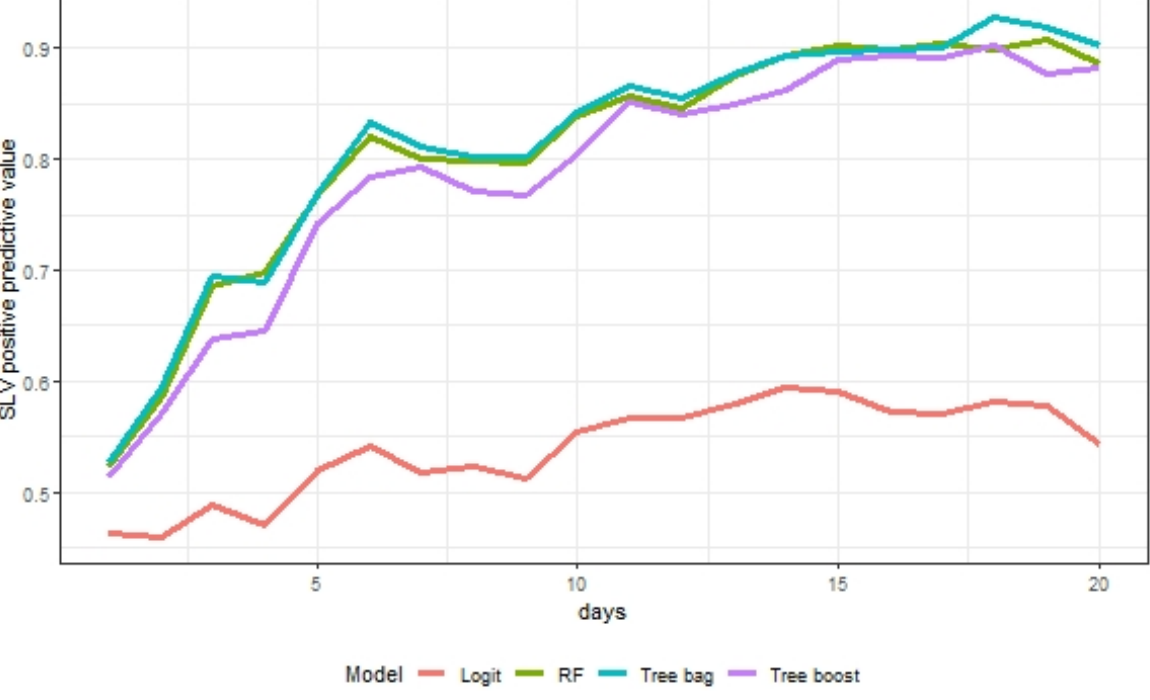
Figure 9. This figure shows the multi-period positive predictive values accuracy for SLV price direction. Figure 10 shows the negative predictive values for GLD. As in the case of the positive predictive values for GLD, RFs and tree bagging provide the most accurate negative pre- dictive values. Tree boosting is slightly less accurate than RFs and tree bagging. The logit model has the lowest accuracy. B e tween 1 and 5 days, accuracy increases from 0.5 to 0.8 for the RFs and tree bagging models. After 10 days, negative predictive values for RFs and tree boosting varies between 0.85 and 0.90. The pattern of negative predictive value for SLV (Figure 11) is similar to what is observed for GLD (Figure 10). For each of GLD and SLV, after 10 days the negative predictive values for RFs and bagging are above 0.80 and in most cases above 0.85.